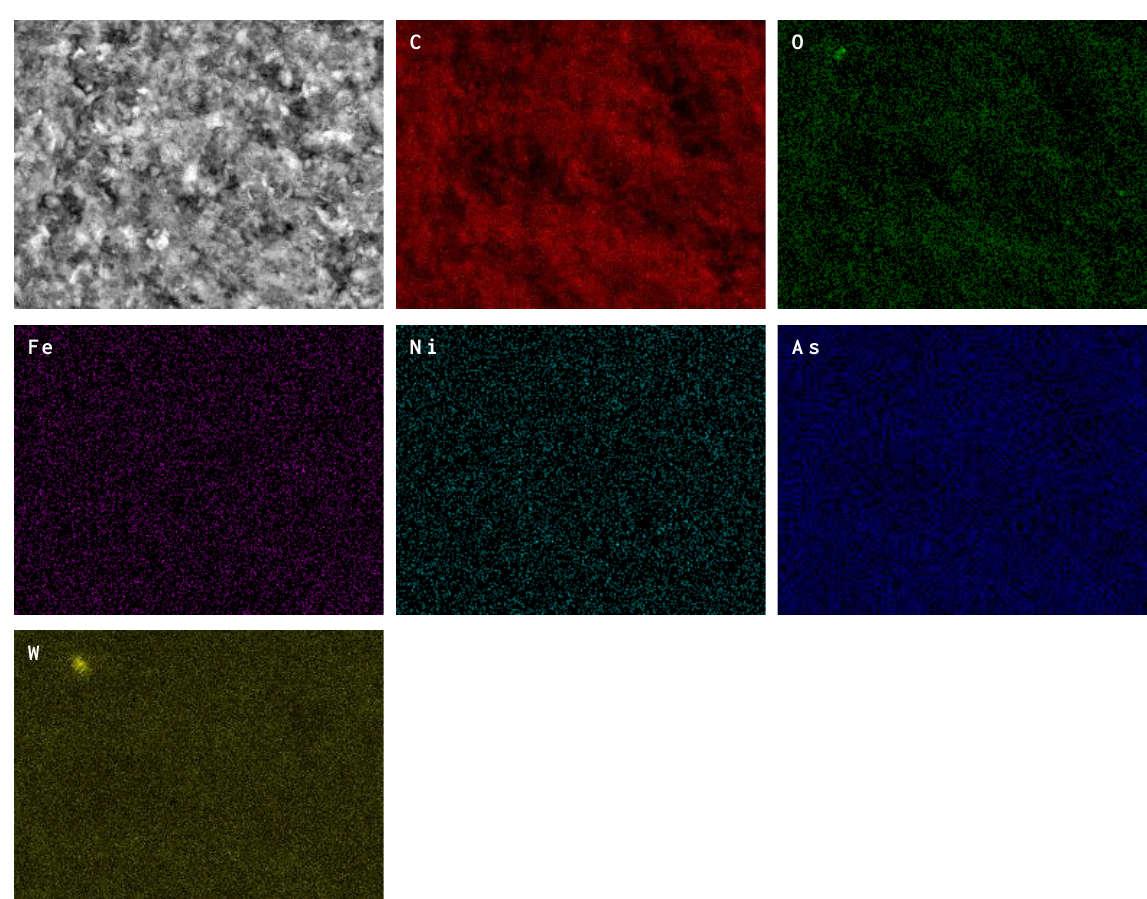
Figure 3. SEM and EDX elemental mapping images of Fe 2 Ni 2 @MWCNT_N6 at ×2500 magnification.